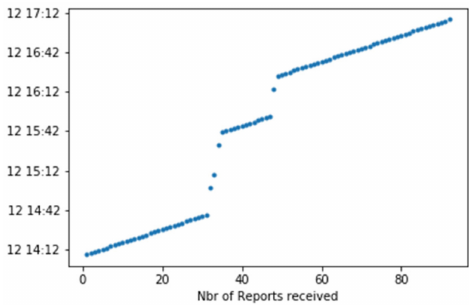
Figure 13. Number of files actually received as a function of time–2 smart meters.